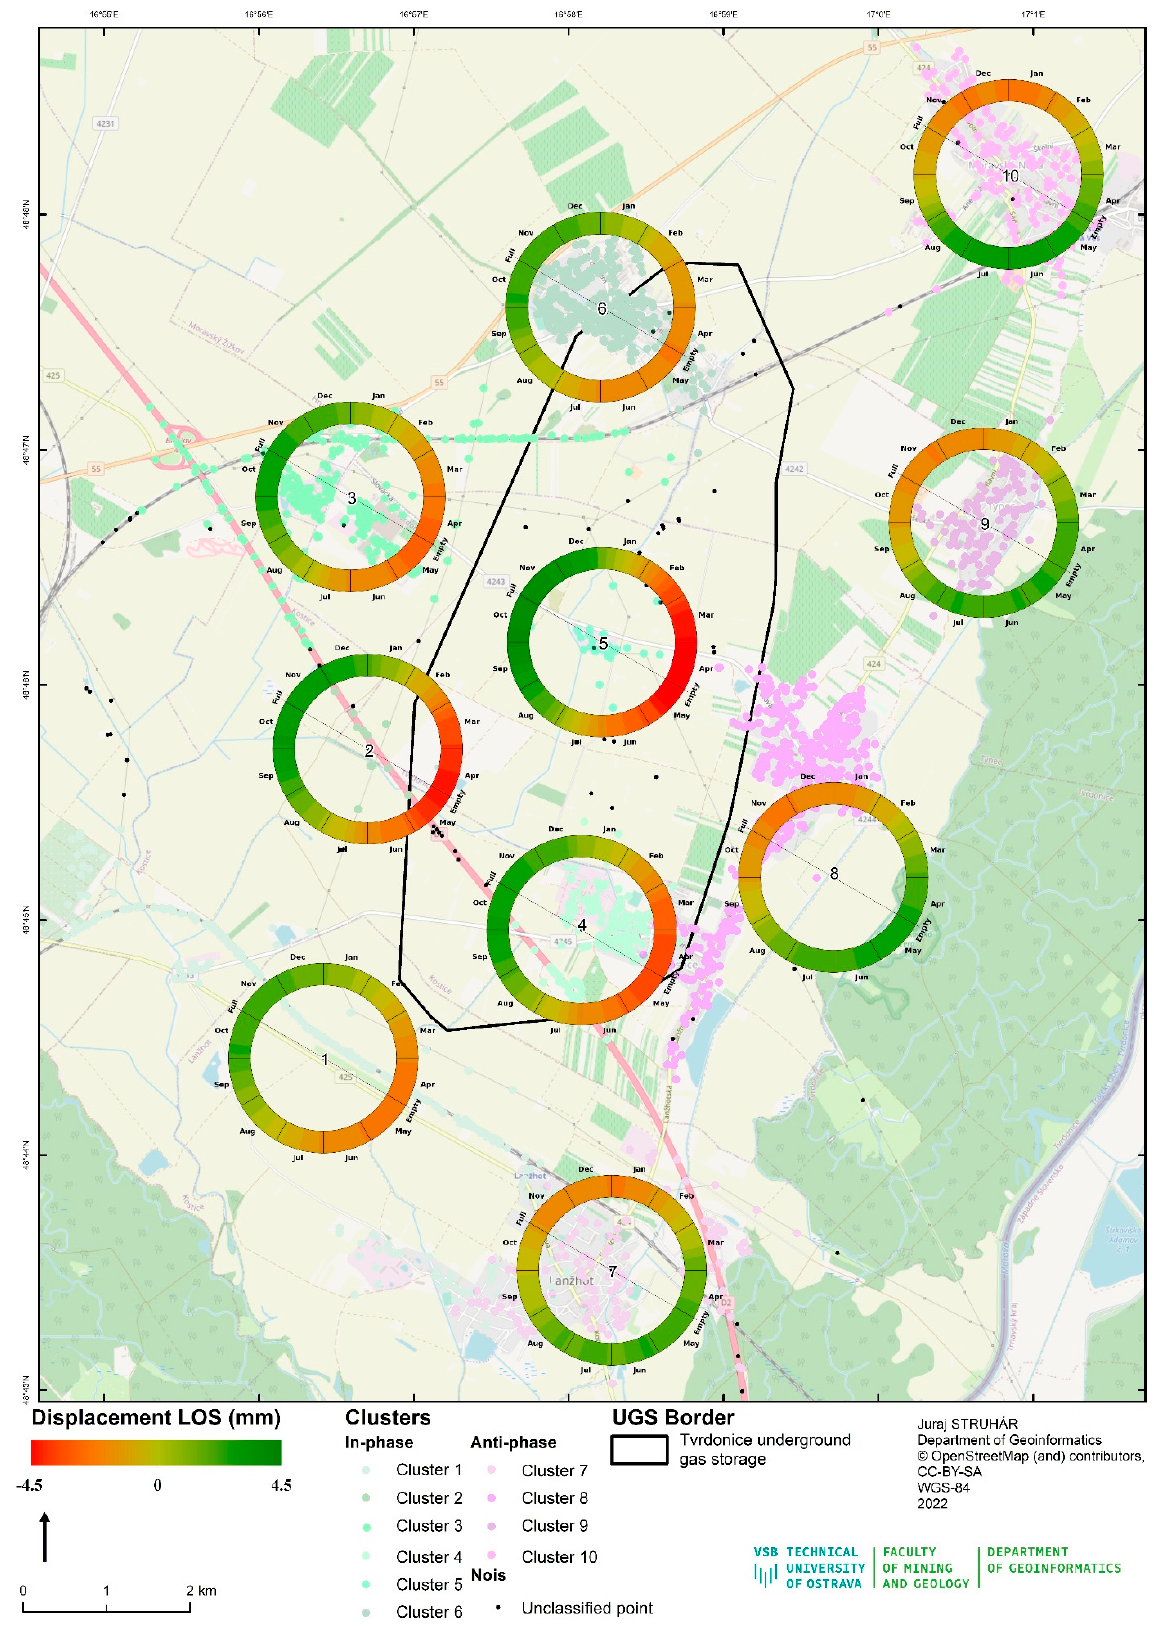
Figure A5. Map composition depicting the distribution of doughnut graphs over cluster centroids in the form of the diagram map using the average annual cycle of terrain movement.